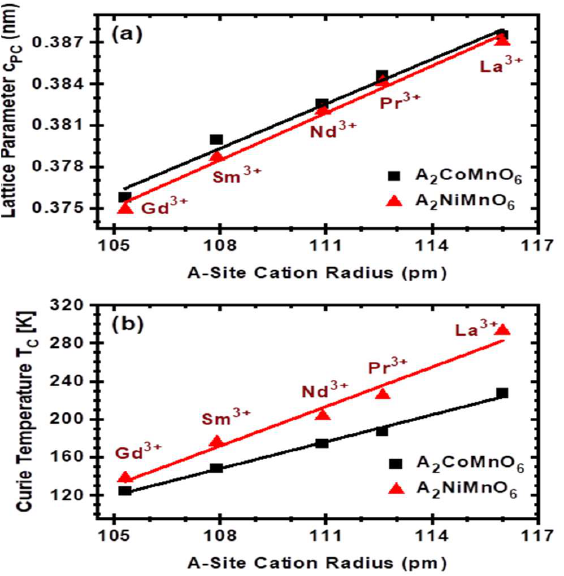
Figure 1. The pseudocubic out-of-plane lattice parameters, c pc , ( a ) and the Curie temperatures, T C , for the paramagnetic-to-ferromagnetic phase transition ( b ) of the B-site-ordered A 2 CoMnO 6 and A 2 NiMNO 6 double-perovskite thin film series on STO(111) as a function of the A-site rare earth cation radius. Both developments exhibit an almost linear behavior in this